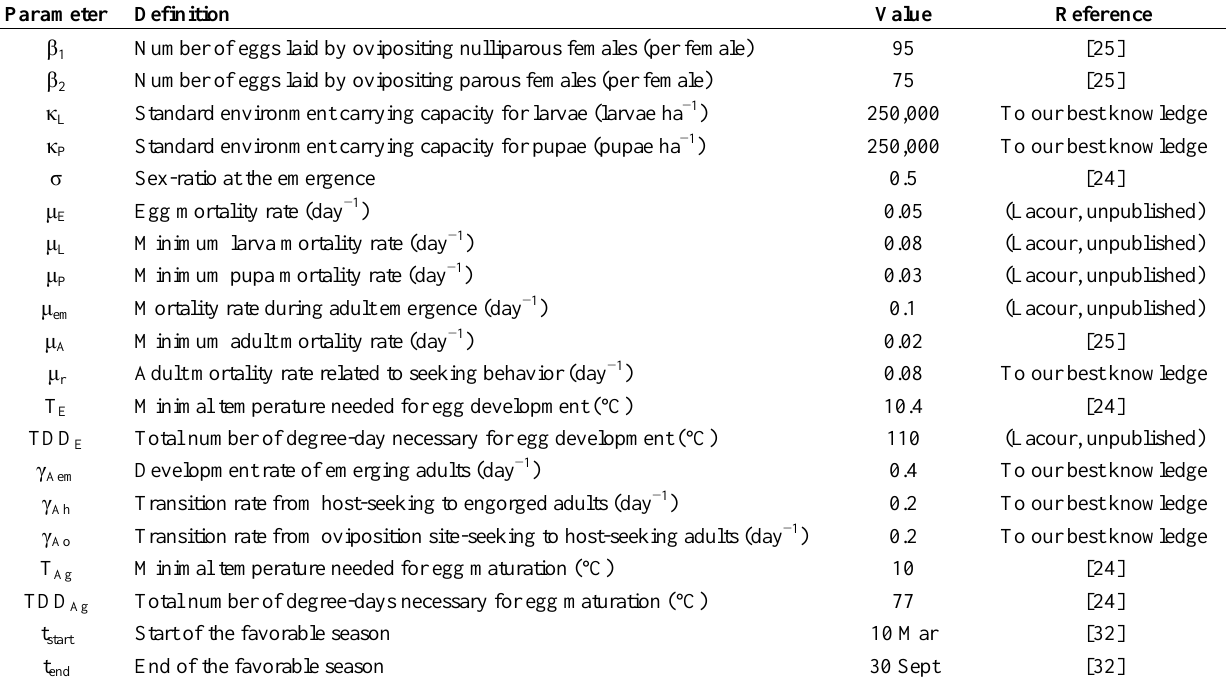
Table 2. Parameter values of the model of mosquito population dynamics adapted to Aedes albopictus in Mediterranean temperate